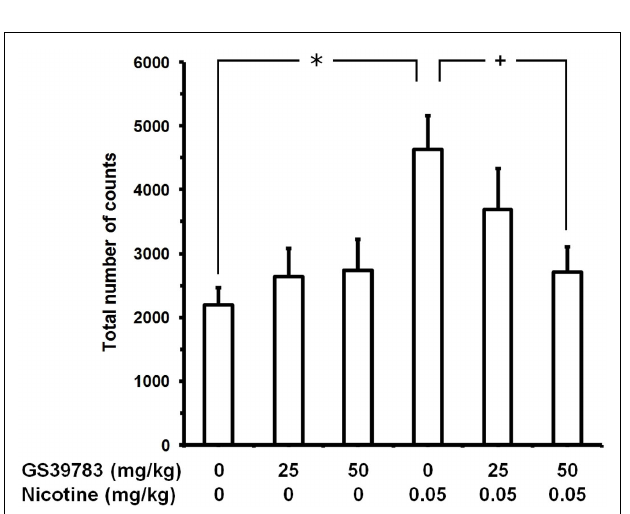
FIGURE 3 | Prevention of nicotine-induced hyperlocomotion by GS39783 in male CD1 mice. Mice were initially treated with GS39783 (i.g.); 60min later, mice were treated with nicotine (tartrate salt). Locomotor activity recording started immediately after nicotine administration and lasted for 20 consecutive min. Data are expressed as mean ± SEM of the total number of counts (photocell breaks) recorded automatically by the apparatus in n = 18 mice. + , P < 0.05 and *, P < 0.01 (Newman–Keuls